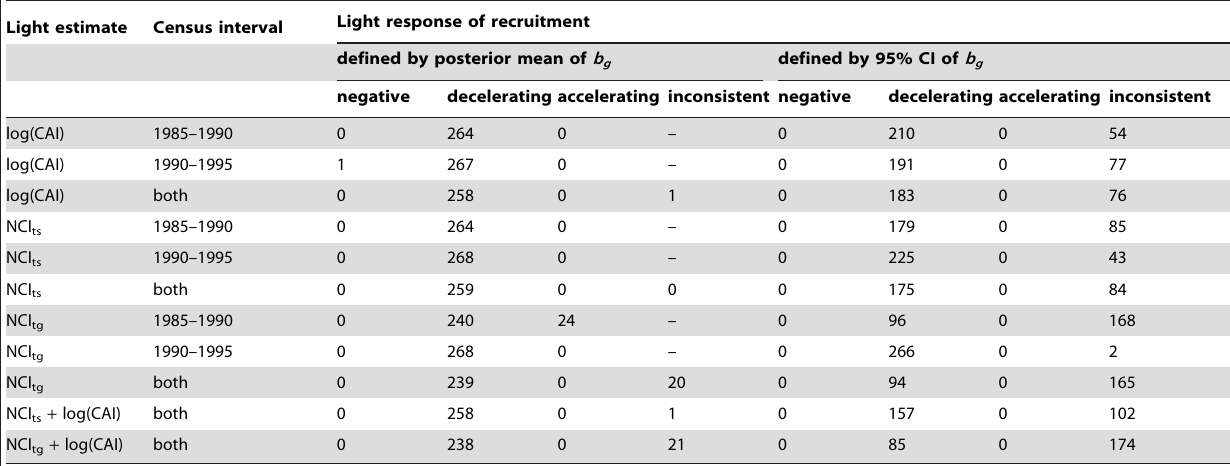
Table 3. Classification of tree species on the basis of their growth responses to light availability: negative ( b g , 0), decelerating (0 , b g , 1) and accelerating ( b g .